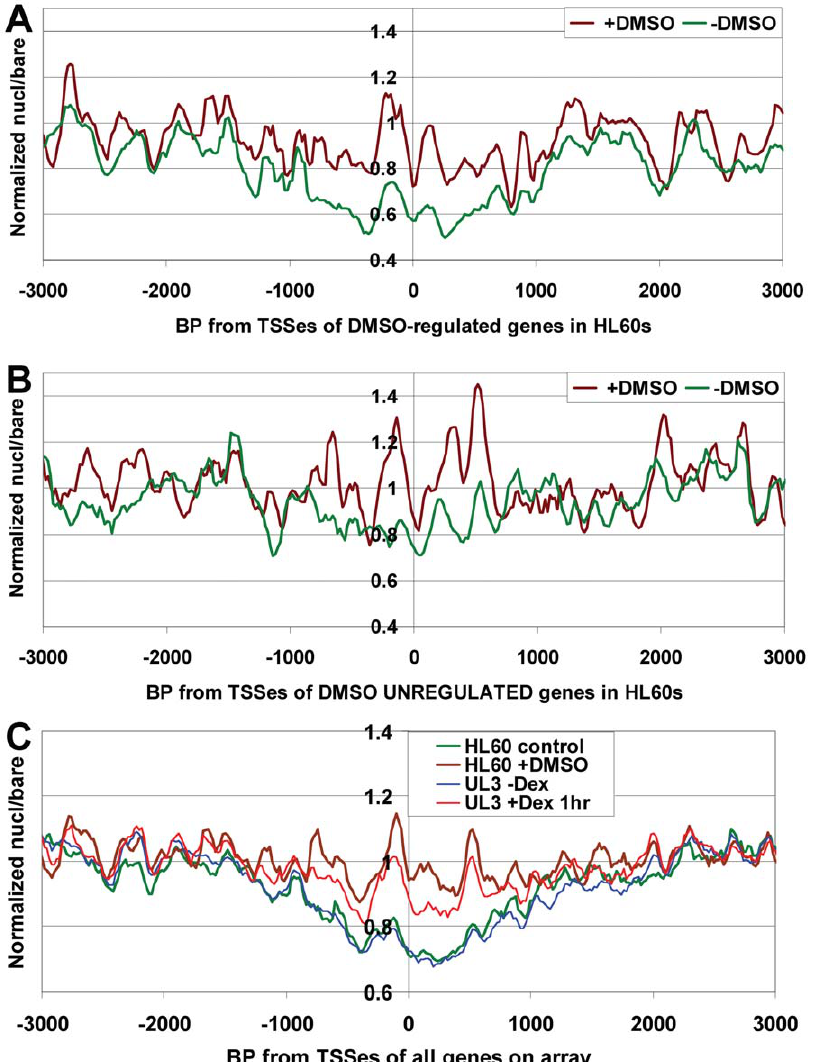
Figure 7. HL60 differentiation to granulocytes is associated with increased promoter nucleosome occupancy. Average quantile- normalized nucleosome occupancy for control HL60 cells versus DMSO-differentiated HL60 cells relative to ( A ) the TSSes of all genes on the array that were significantly up- or down-regulated by 5-day DMSO treatment (up: MYC , CCNE1, CCND1, CCNB2 , CD44 & ZBTB16 , down: GAPDH & SGK1 , [59]), or ( B ) all genes on the array that were not regulated by DMSO treatment (showing expression levels well above background and less than a 1.3-fold change with DMSO treatment: CDK1 , E2F1 , CSF1 , SRGN & TSC22D3 , [59]). A similar effect was seen for both up- and downregulated genes, when analyzed separately (data not shown). ( C ) Comparison of average nucleosome densities for control conditions (–Dex for UL3s, –DMSO for HL60s) and after stimulation ( + Dex 1 hr for UL3s, + DMSO 5 days for HL60s). Plots showing that increased occupancy + DMSO is only seen for promoter regions (at any given nucl/bare ratio in –DMSO samples) are shown in Fig. S3C &